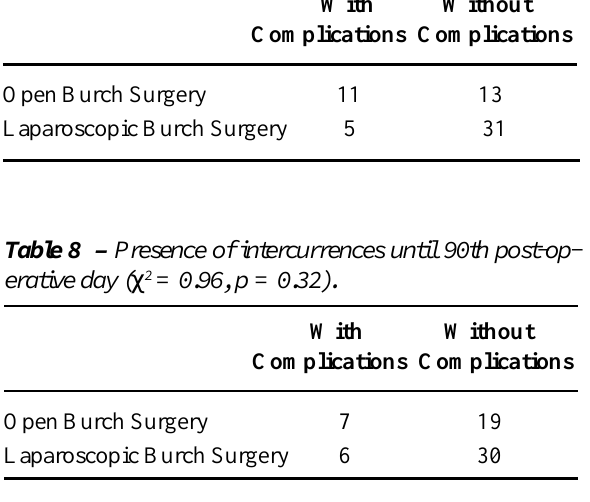
Table 5 – Assessment of patients on the 90th postoperative day ( c 2 = 0.70, p = 0.77).